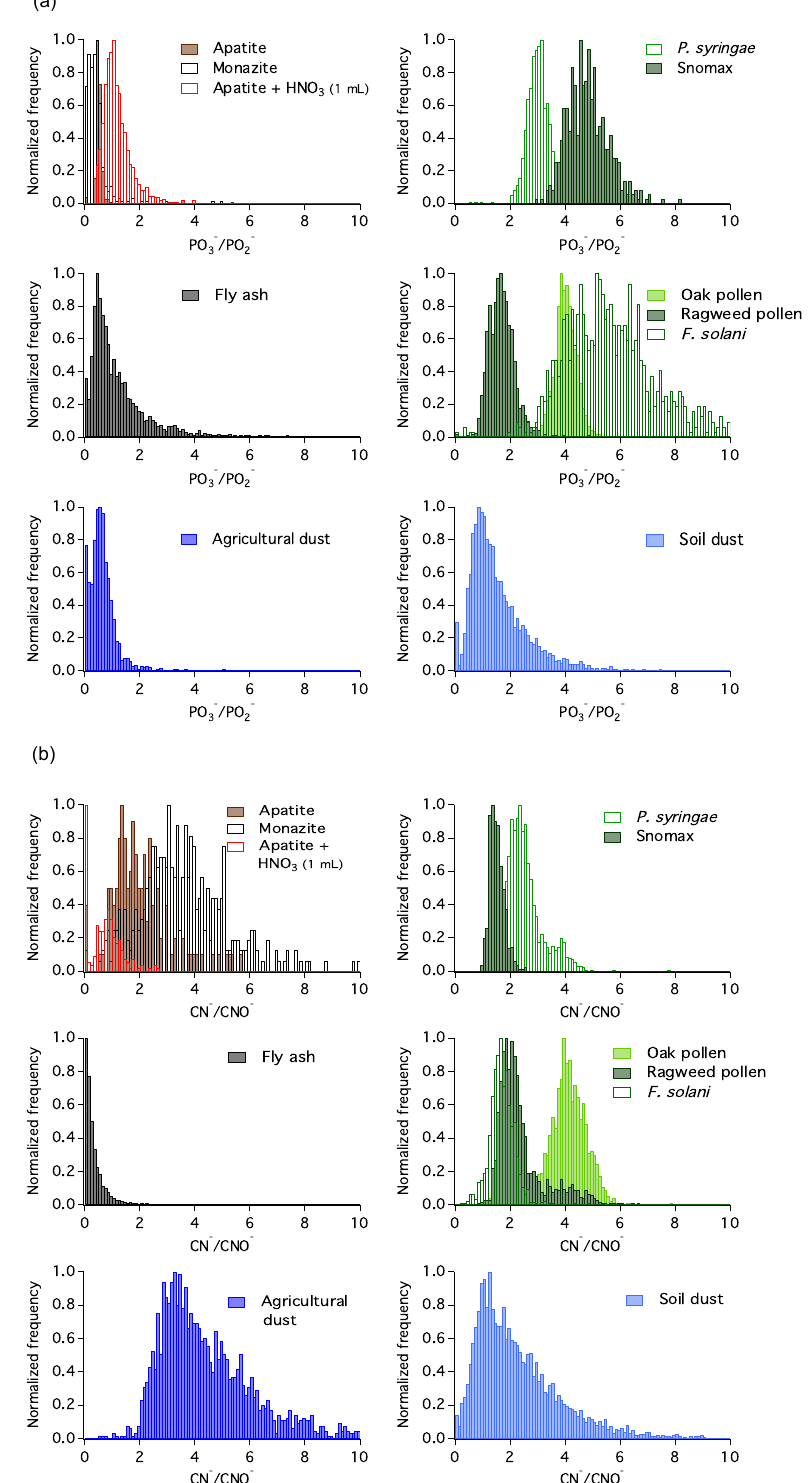
/ PO − ratio for the laboratory aerosol. (b) Normalized histograms of the CN − / CNO − 3 2 / PO − ratio of 3 results in a 70–80% classification 3 2